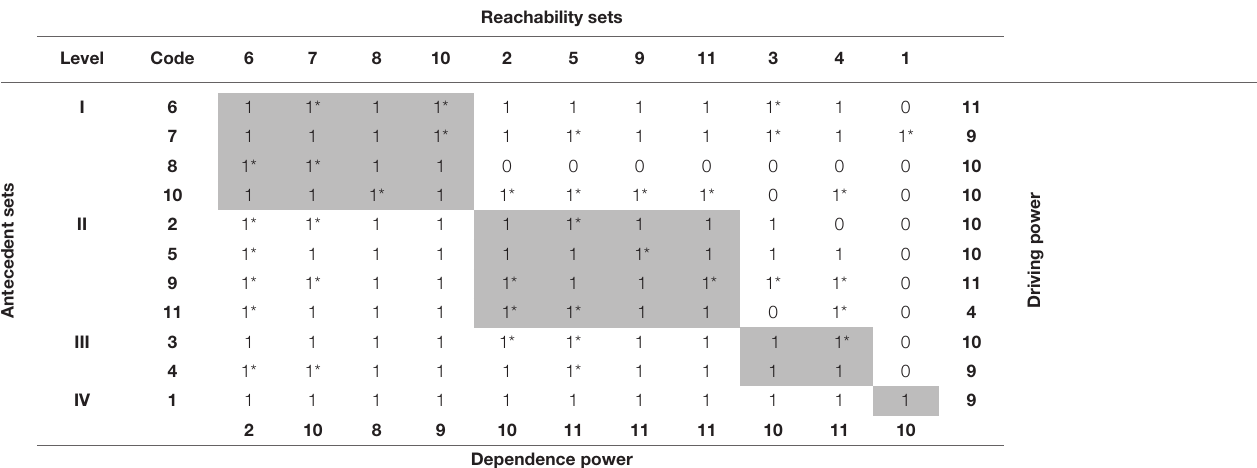
TABLE 10 | Condensed presentation of ISM.